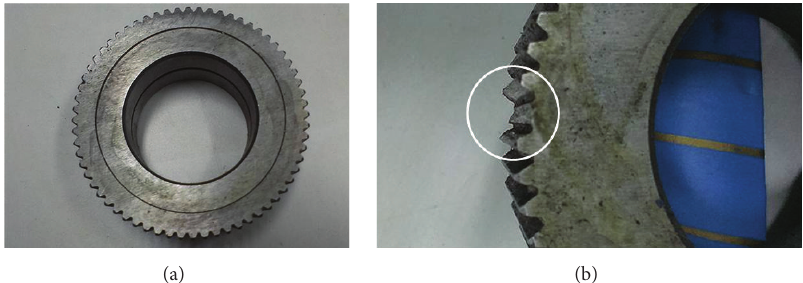
Figure 5: The normal planet gear and the artificially seeded faulty gear. (a) Normal planet gear; (b) artificially seeded faulty gear.